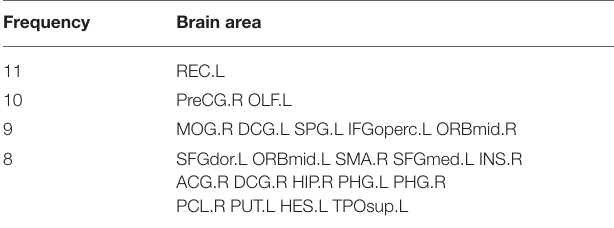
TABLE 4 | The performance of our WRSVMC and existing SVM